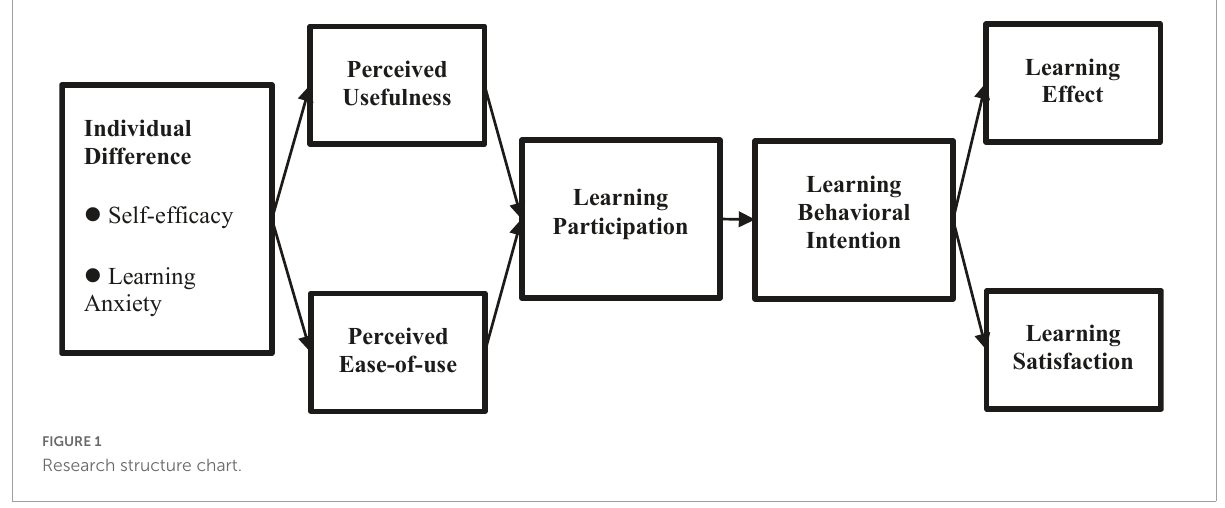
FIGURE1 Research structure chart.